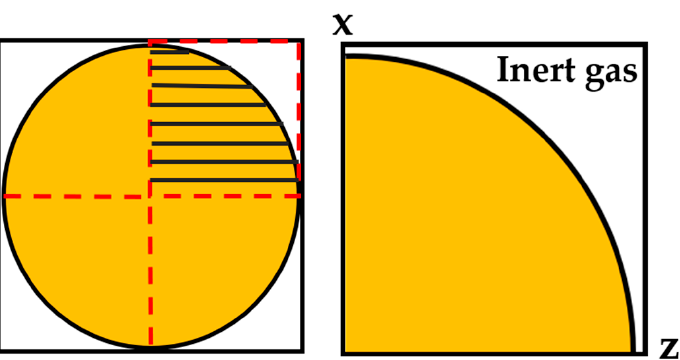
Figure 1. Two ‐ dimensional geometric model of droplet solidification. Figure 1. Two-dimensional geometric model of droplet